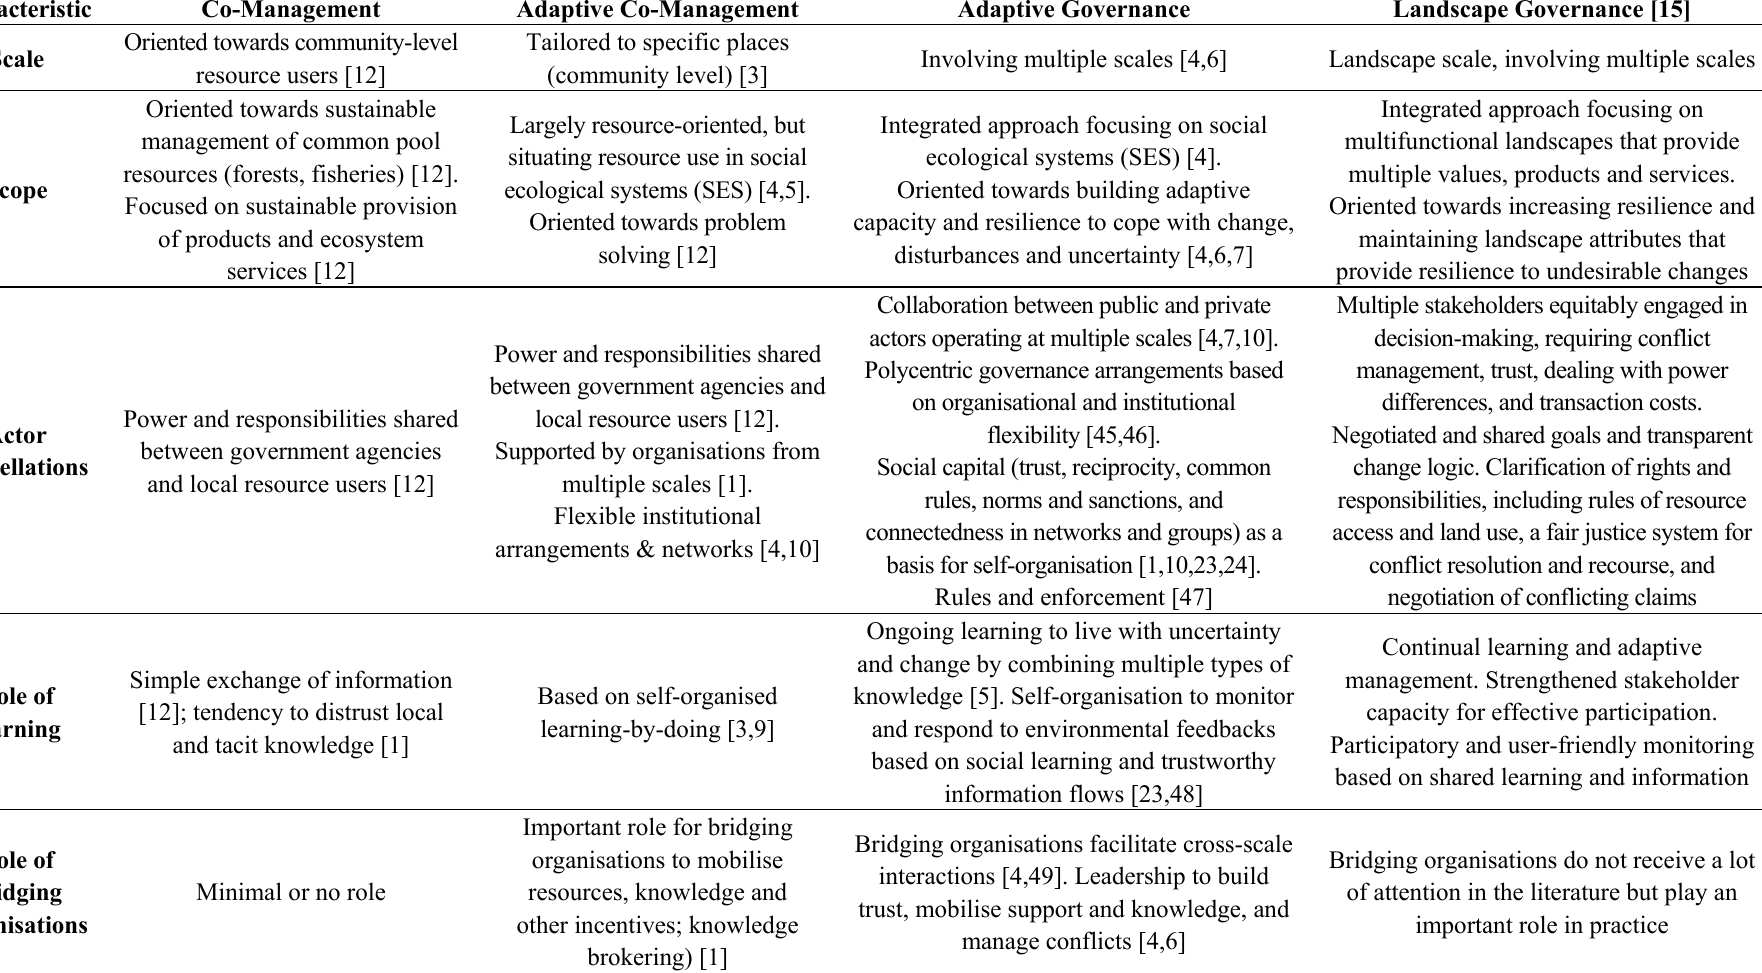
Table 1. Characteristics of adaptive co-management, co-governance and landscape